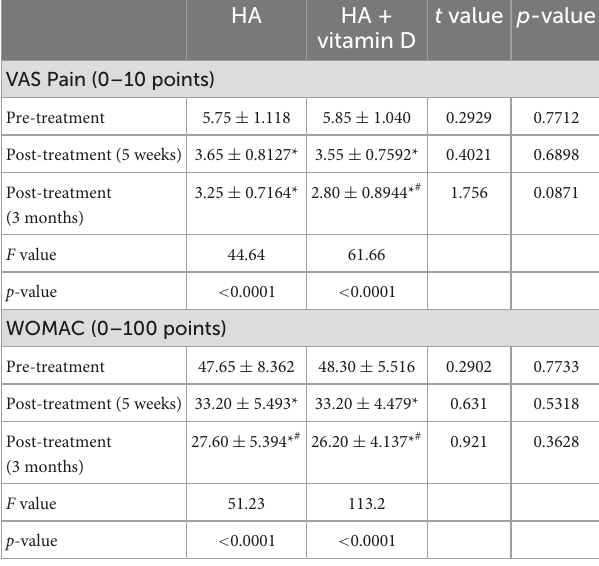
*Represents the comparison between pre- and post-treatment; # represents the comparison between post-treatment (5 weeks) and post-treatment (3 months). HA, hyaluronic